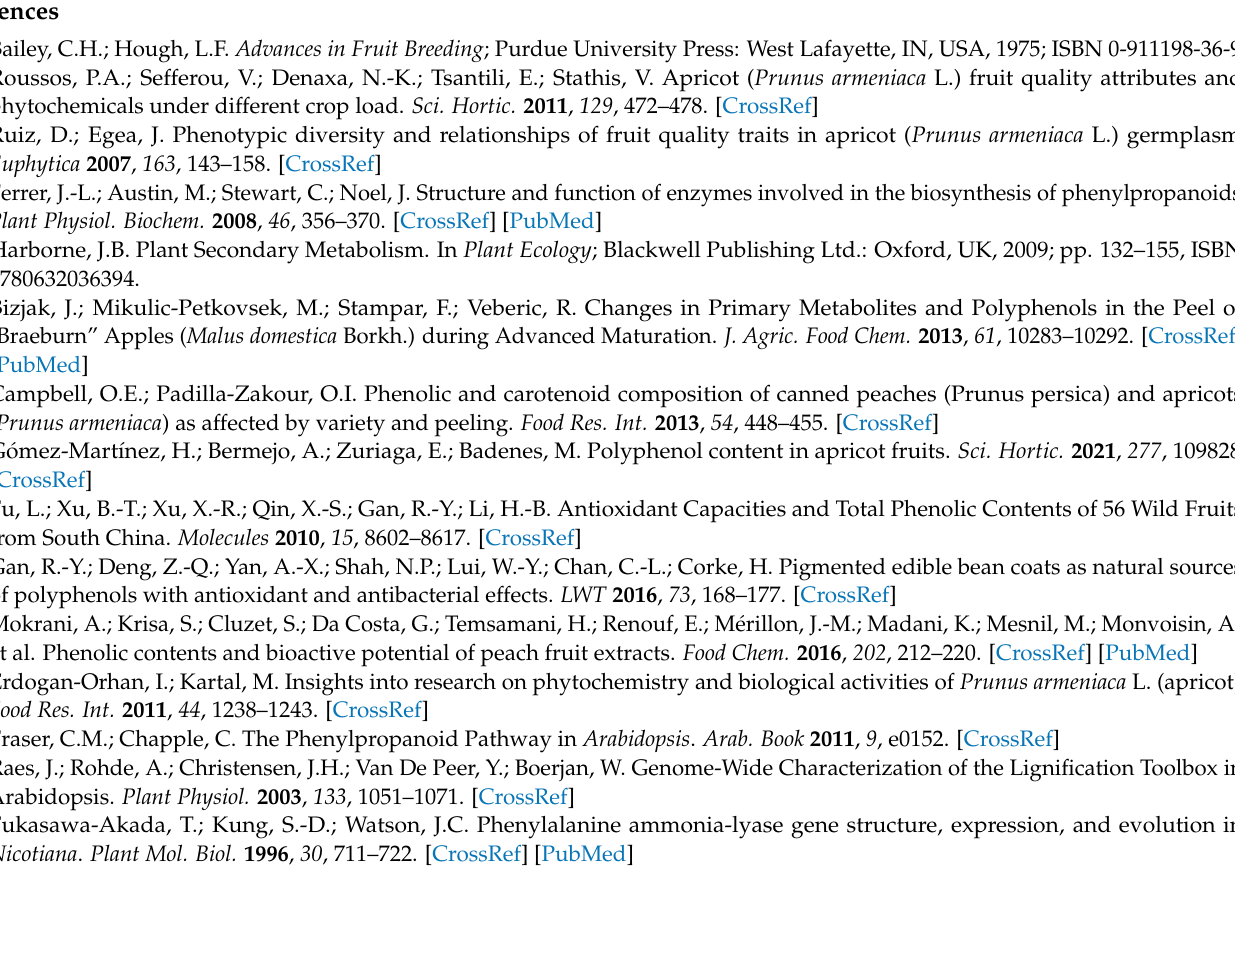
studied genotypes. Different letter means significant differences among genotypes. Table S7: Linear regression model in caffeate-derivates content. Table S8: Linear regression model in flavonols content. Figure S1: Standard Chromatogram and retention times. Figure S2: ‘Canino’